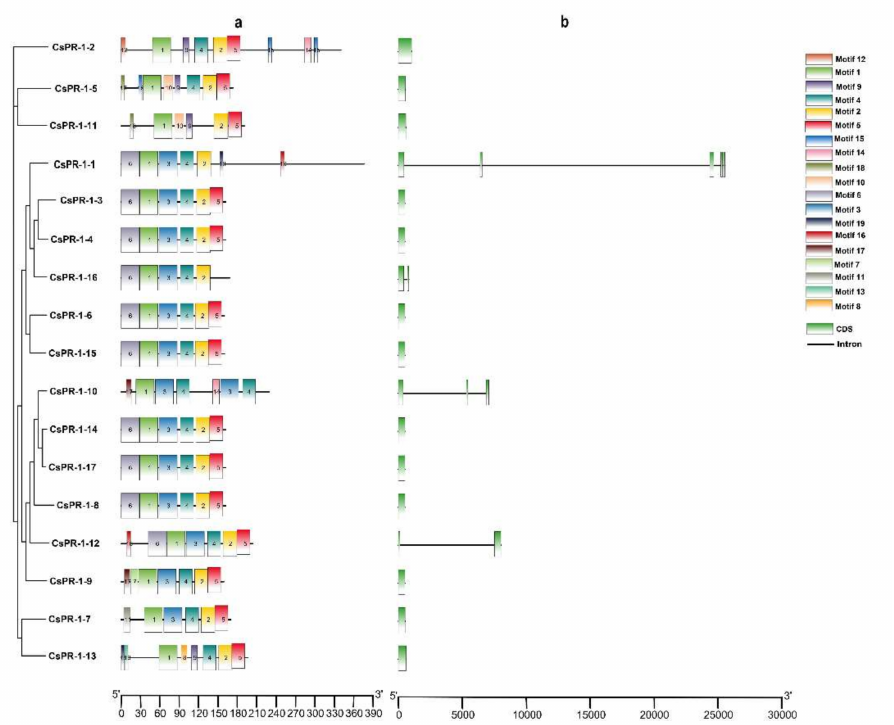
Figure 2. Phylogenetic clustering, motif compositions, and gene structures of the CsPR-1 family members in tea plants. ( a ) The motifs of each CsPR-1, as well as 20 different motifs, are represented by different colored boxes. ( b ) Exon-intron structural analyses of CsPR-1 .